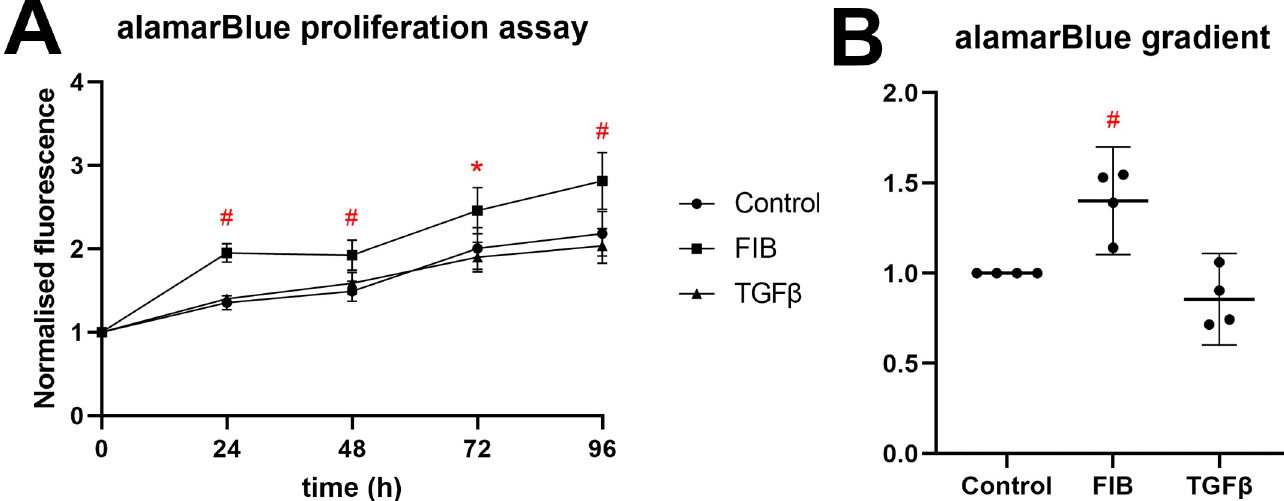
Fig 2. FIB media is pro-proliferative. (A) Fluorescence data from alamarBlue proliferation assay (n = 4), normalised to day 0. The two treatment groups were compared to control at each time point using an ordinary 2-way ANOVA and (B) the gradients of the line of best fit derived from a simple linear regression model of 4 repeats, normalized to control. Both treatments were compared to control using an ordinary one-way ANOVA. � p < 0.05, #p < 0.01.